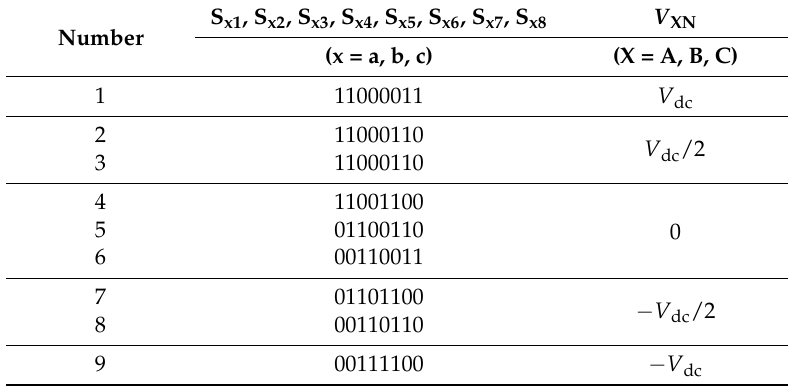
Table 2. Switching states of the NPC/H bridge five-level inverter.